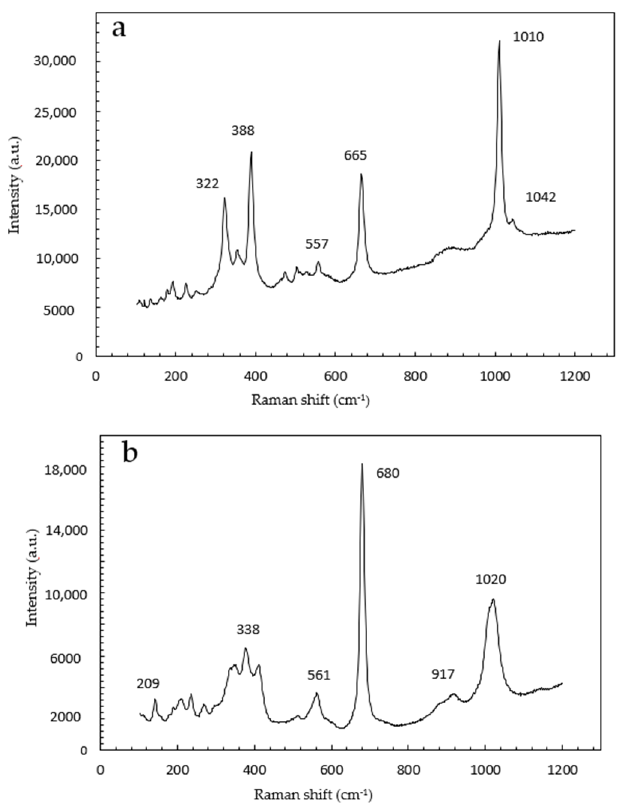
Figure 11. Raman spectra of point 7, diopside ( a ), and point 3, omphacite ( b ). As it is shown in Figure 10, points presenting violet color, even if with little different hues, correspond both to diopside and omphacite: points 3, 4, 13, 15, and 16 resulted omphacite and points 7 and 8 diopside. Points 5, 11, and 19 with a whitish color resulted diopside.